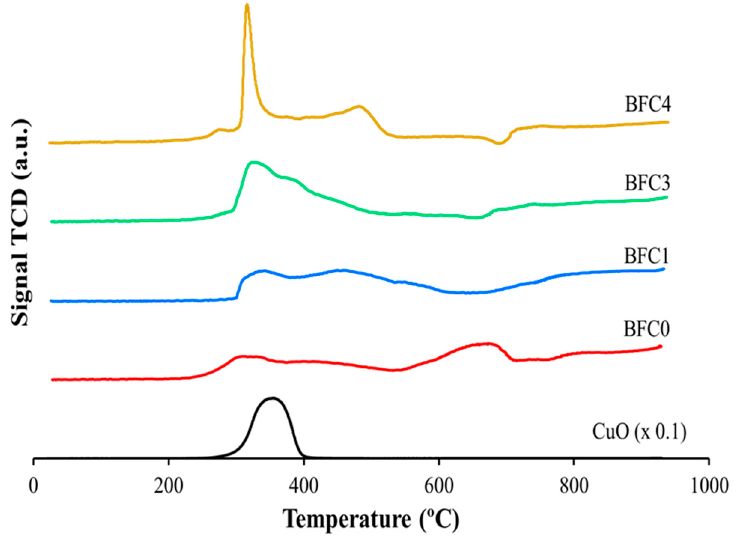
Figure 6. H 2 -TPR profiles for BaFe 1-x Cu x O 3 catalysts.